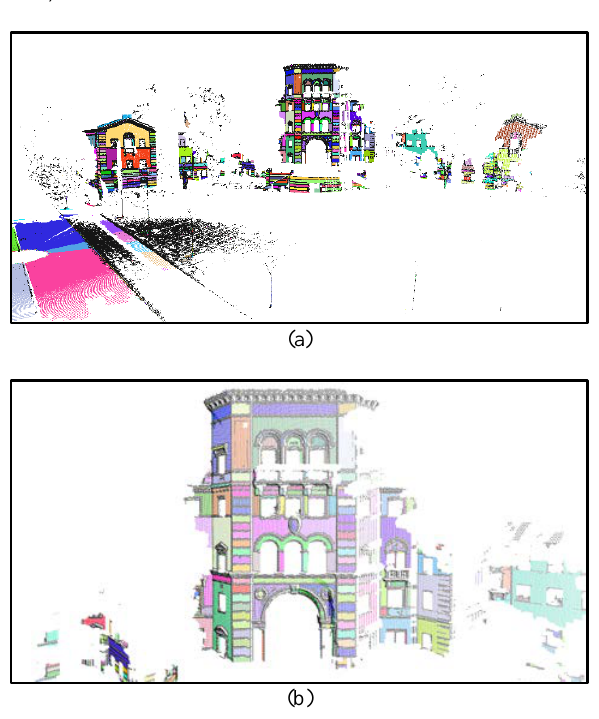
Figure 7. (a)Segmentation results for the scan down-sampled by 1/9; (b) close-up view for the segmented building